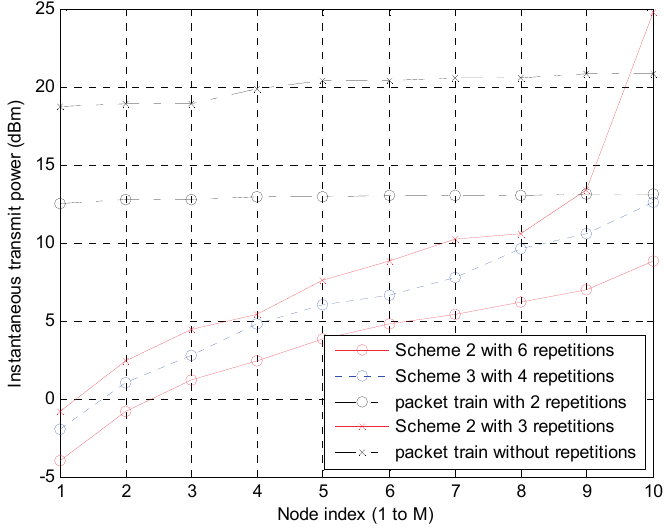
Figure 13. Transmit power of each node when the node is on the transmission